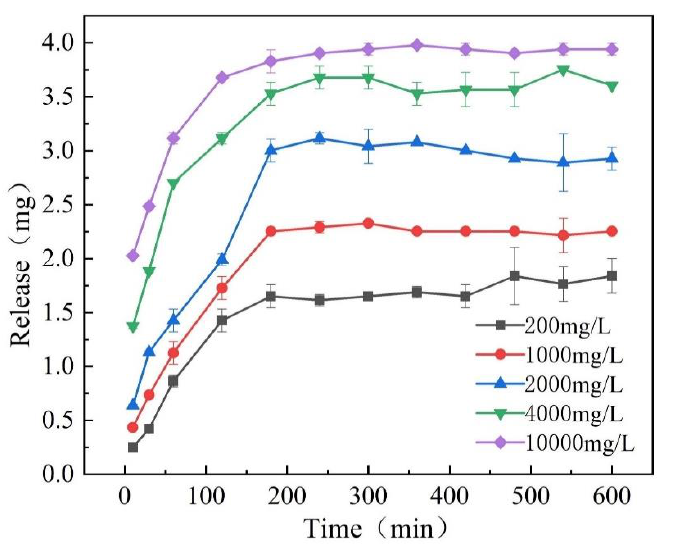
Figure 8. The effect of different NaCl concentrations on the slow release of ammonia